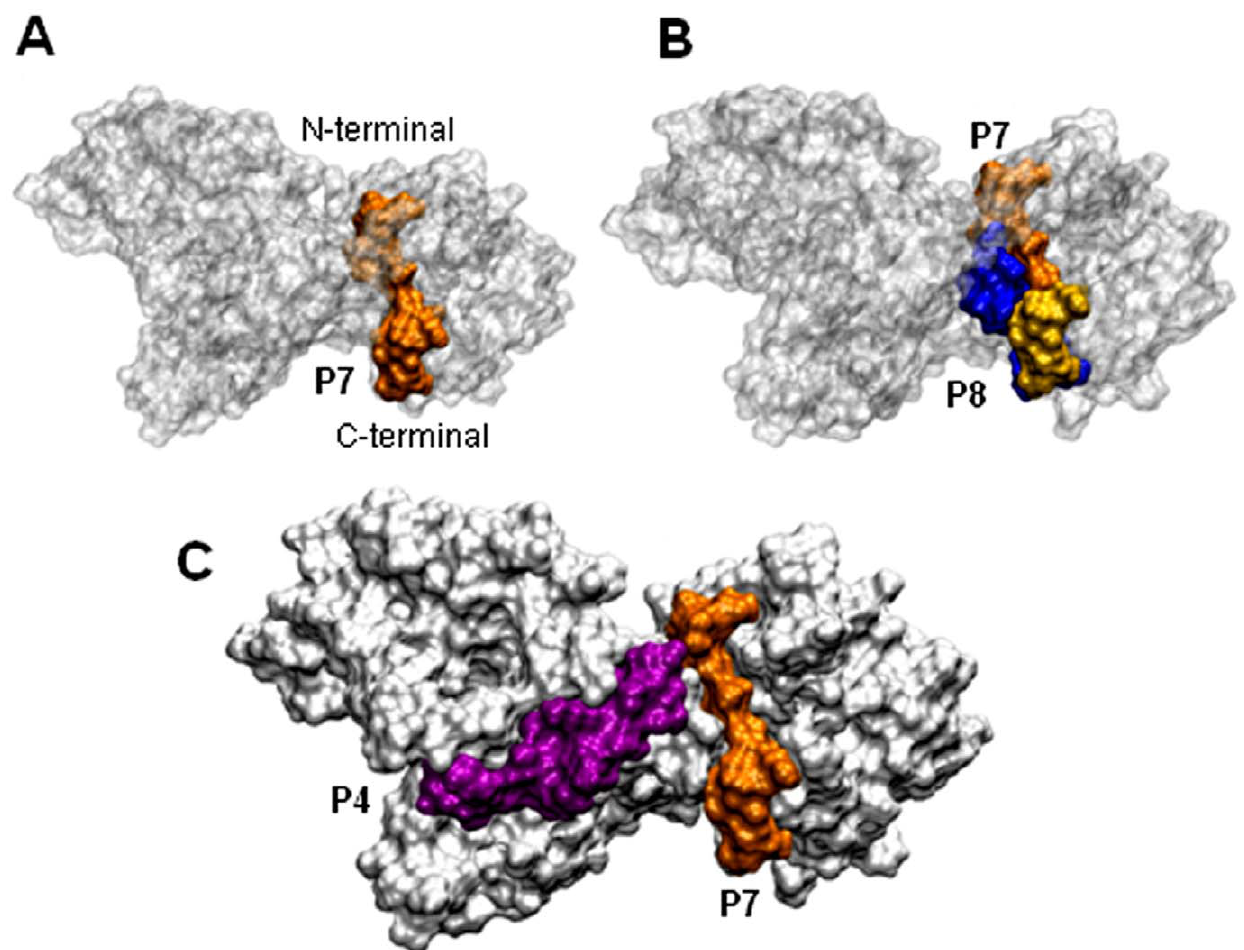
Figure 5. Surface representation of gp82 showing the gastric mucin-binding site. A) P7, the gastric mucin-binding site is highlighted in orange. B) Shown is the site P7 (orange) overlapped (yellow) with the cell binding site P8 (blue). C) The relative localization of P7 (orange) and the cell binding site P4 (magenta).